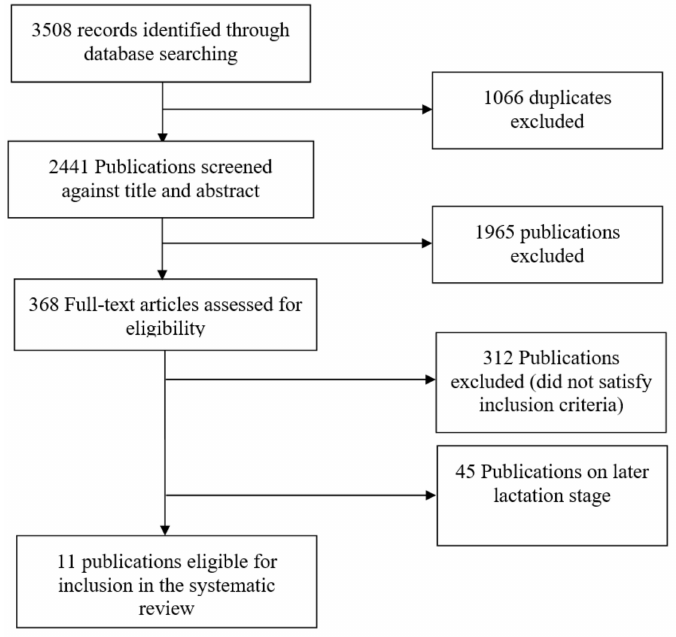
Figure 1. Publication selection procedure. The flow chart depicts systematic steps of title, abstract and full-text screening as independently conducted by two